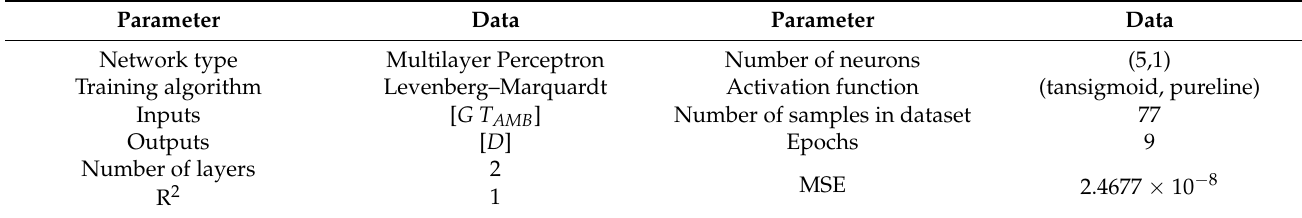
Table 3. Main parameters of the ANN.